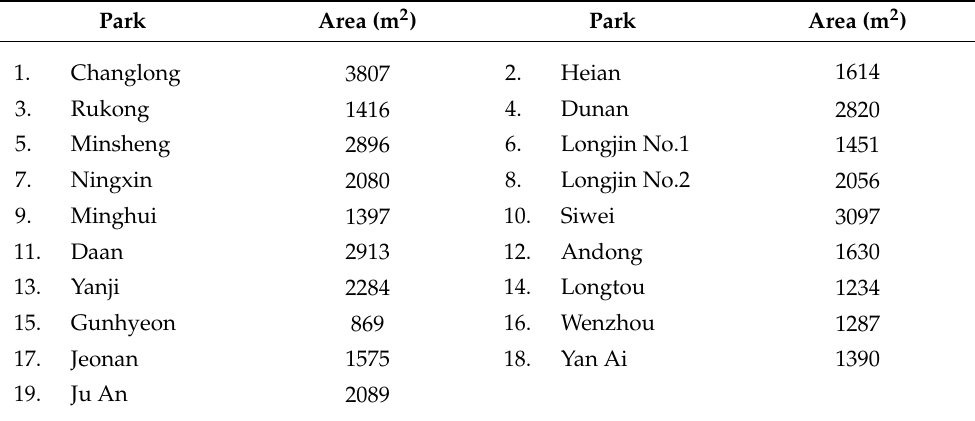
Table 1. List of neighborhood parks used in this